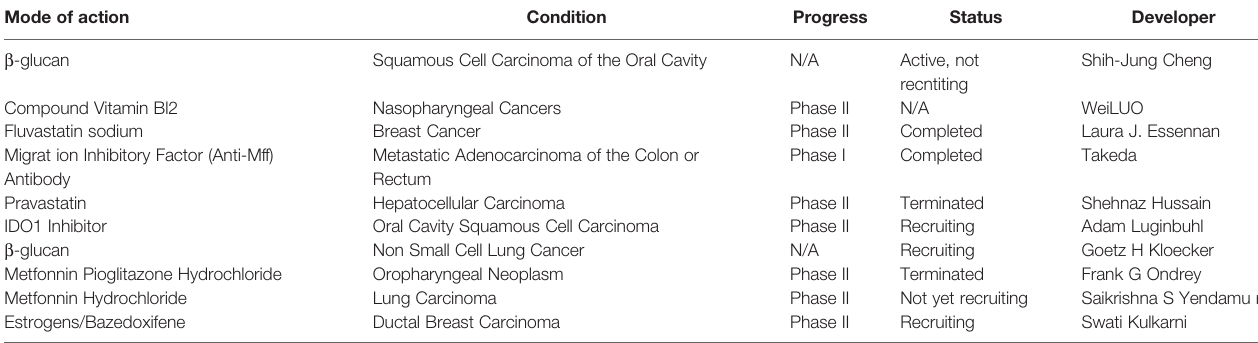
TABLE 1 | The action under clinical development as of October 1st, 2021, for oncological indications; source, http://www.clinicaltrials.gov. Mode of